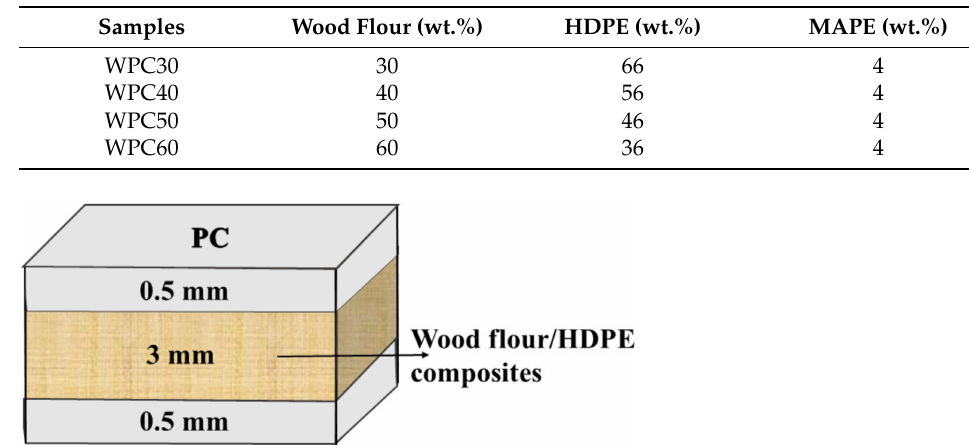
Table 1. Formulations of the wood flour/HDPE composites.